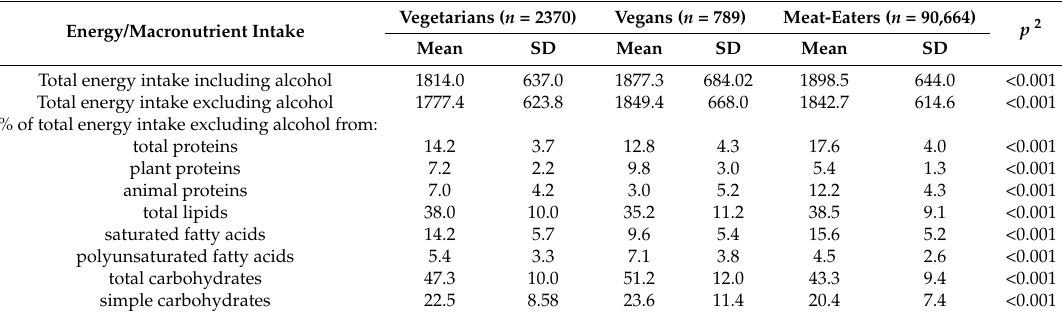
Table 5. Energy intake and contribution of macronutrients to energy intake among vegetarians, vegans, and meat-eaters (Nutrinet-Sant é Study 2009–2015, n = 93,823) 1 . Energy/Macronutrient Intake